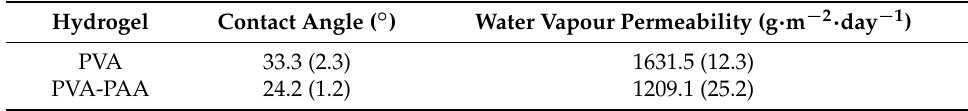
Table 1. Change in contact angle and permeability, mean (95% CI), of PVA and PVA-PAA samples.